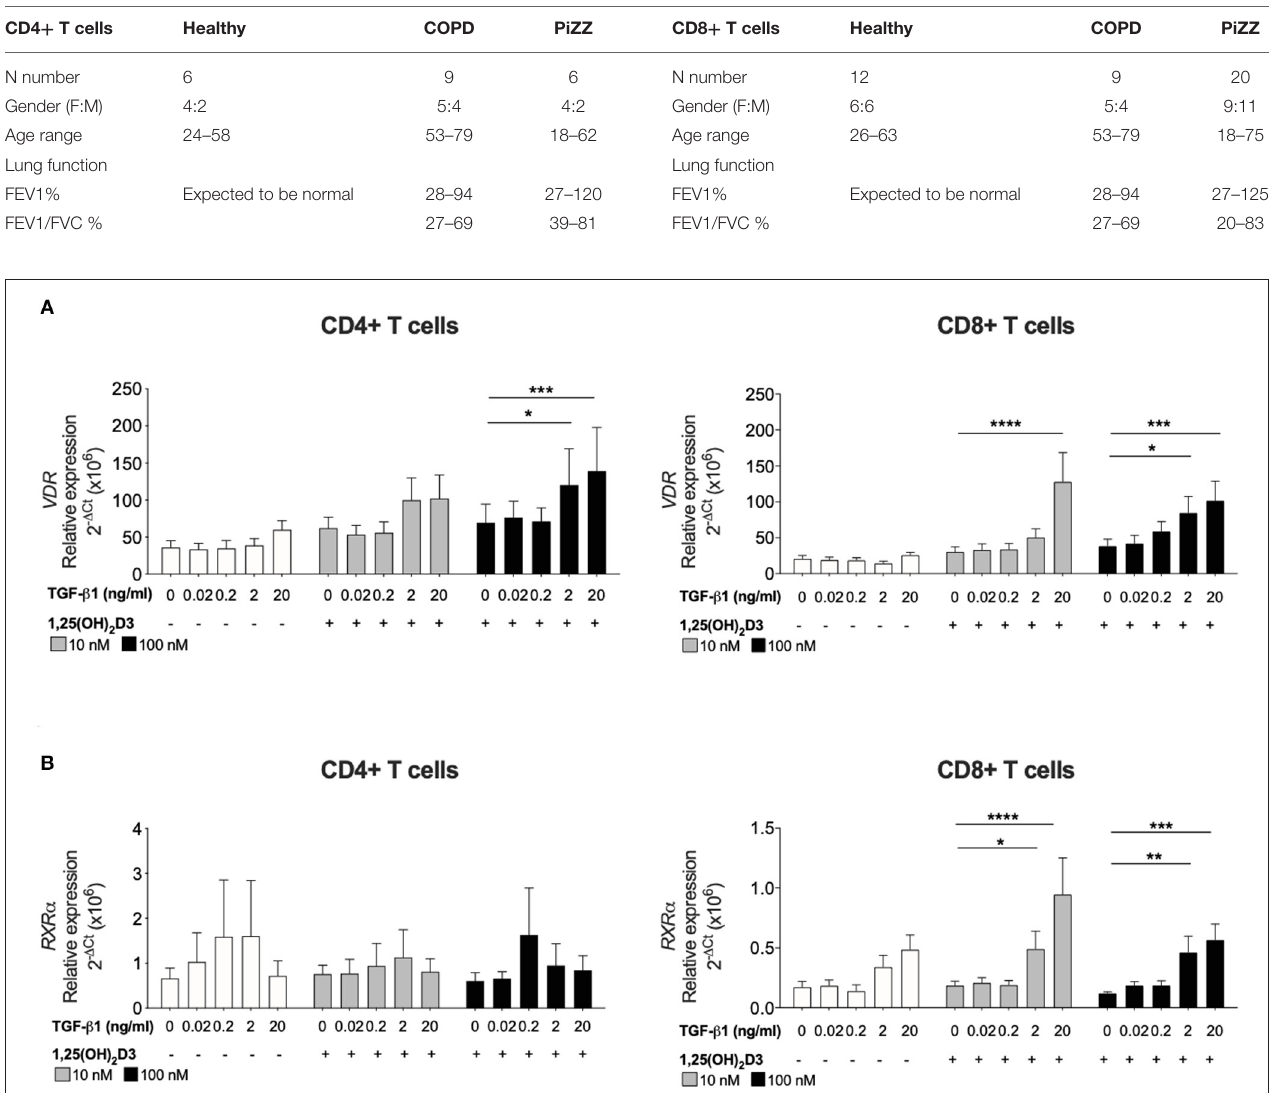
TABLE 1 | Clinical parameters of healthy control, COPD, and PiZZ patients.